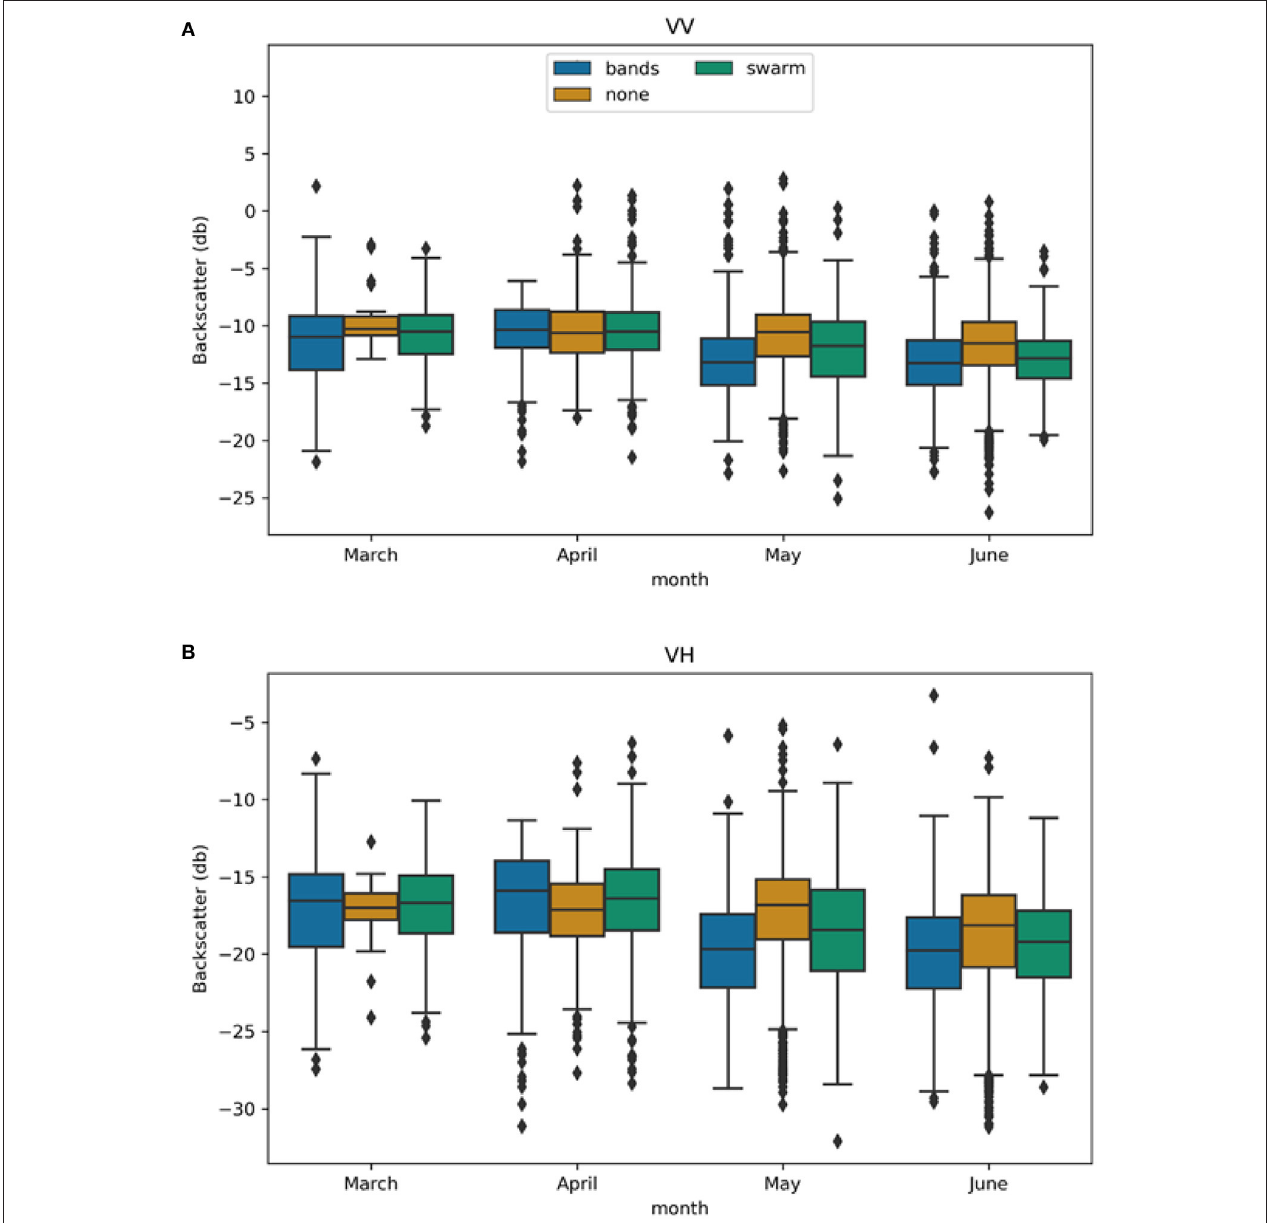
FIGURE 7 | Box plots of monthly VV (A) and VH (B) median backscatter power from Sentinel 1 C-band at swarm, band, and non-locust locations for March through June